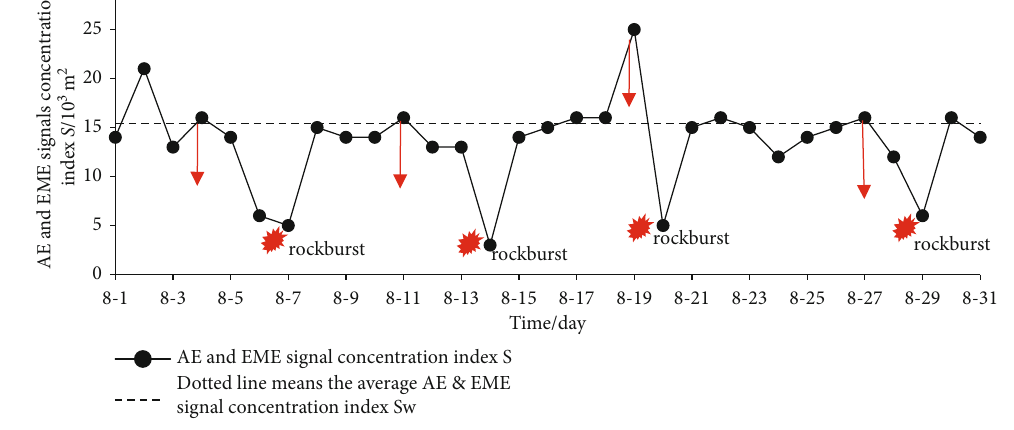
Figure 7: The concentration index S of the AE and EME strength from Aug 1 to 31. Table 1: Static evaluation method of AE-EME-MS coupling monitoring.